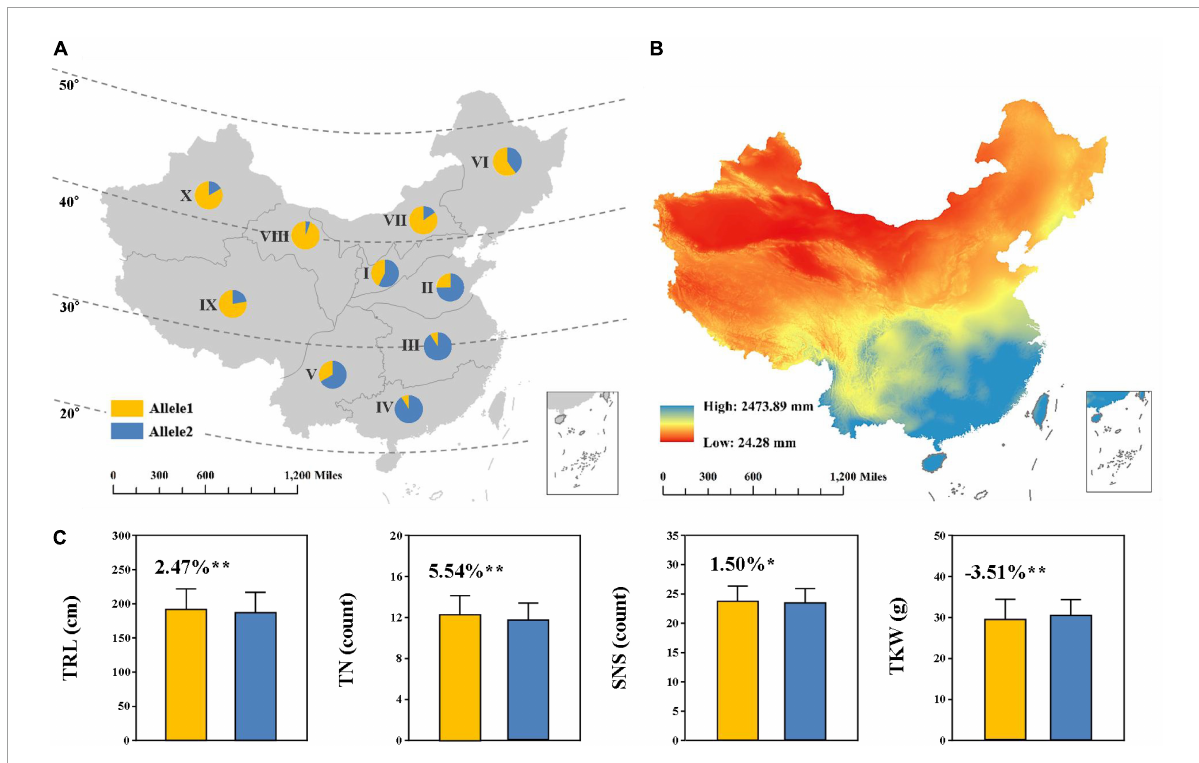
FIGURE5 Geographic distribution (A) and effects (C) of QTrl.sicau-2SY-4D in Chinese wheat landraces (CWL) across 10 Chinese agro-ecological zones. Allele1 and Allele2 represent lines with and without the positive alleles of QTrl.sicau-2SY-4D , containing 207 and 369 lines, respectively. * and ** mean significant difference at P < 0.05 and 0.01 probability level. Lines with heterozygous alleles were excluded. The annual precipitation data during 2000–2015 in China (B) was provided by the Resource and Environment Science and Data Center, Institute of Geographic Sciences and Natural Resources Research (http://www.resdc.cn).